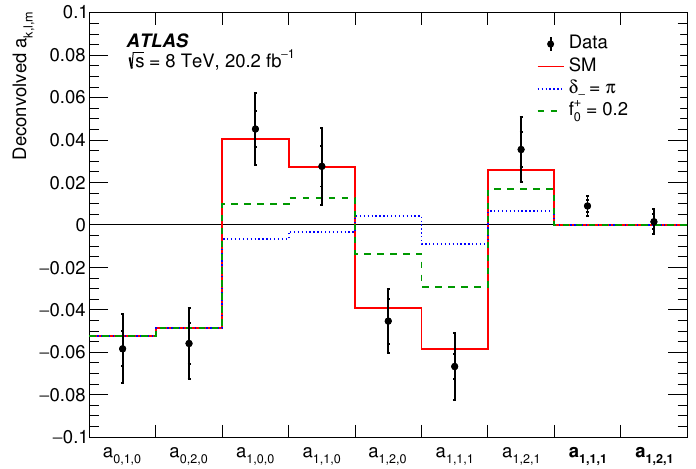
Figure 8. Deconvolved angular coe(cid:14)cients from data using the migration matrix from the SM simulation. Data are shown as black points with statistical uncertainties (inner error bar) and statistical and systematic uncertainties added in quadrature (outer error bar), while SM prediction is shown as a red line. In addition, two new physics scenarios, one with (cid:14) with f + = 0 : 2, are also shown as a dotted blue line and dashed green line, respectively. The x -axis 0 shows the real and imaginary parts of the angular coe(cid:14)cients, where the latter appears in boldface.